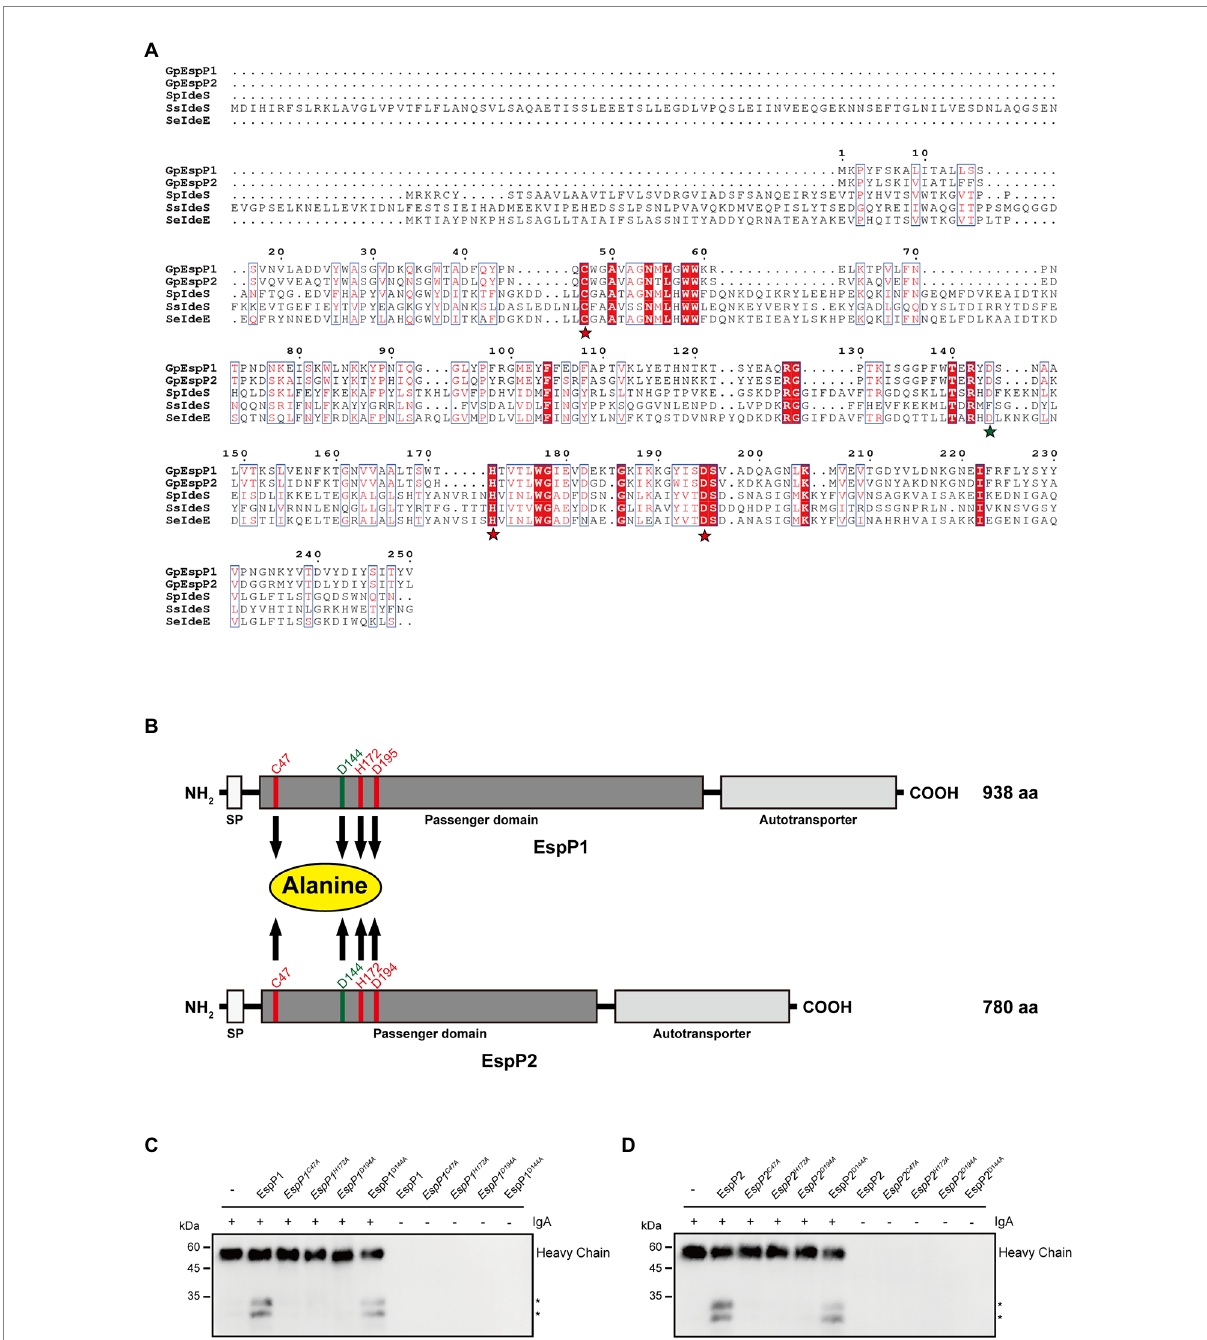
FIGURE 3 Protease activity of EspP1 and EspP2 are affected by the putative active sites which consisted of cysteine, histidine and aspartate. (A) The multiple- sequence alignment of G. parasuis EspP1 (aa 1-250) and EspP2 (aa 1-249) amino acids with the published sequence of S. pyogenes IdeS (aa 1-341), S. suis IdeS (aa 1-454) and S. equi IdeE (aa 1-349). The putative active sites were marked with yellow stars, and the D144 was acted as control, which was marked with a green star. (B) Schematic of EspP1 and EspP2. Positions of C47, H172, D194/D195, and D144 were highlighted and these amino acid residues were mutated to alanine separately. Protease activity of EspP1 (C) and EspP2 (D) disappeared when Cys-47, His-172, or Asp- 194/Asp-195 were mutated to alanine (Ala). And the degradation activity of EspP1 D144A and EpspP2 D144A were not affected by the